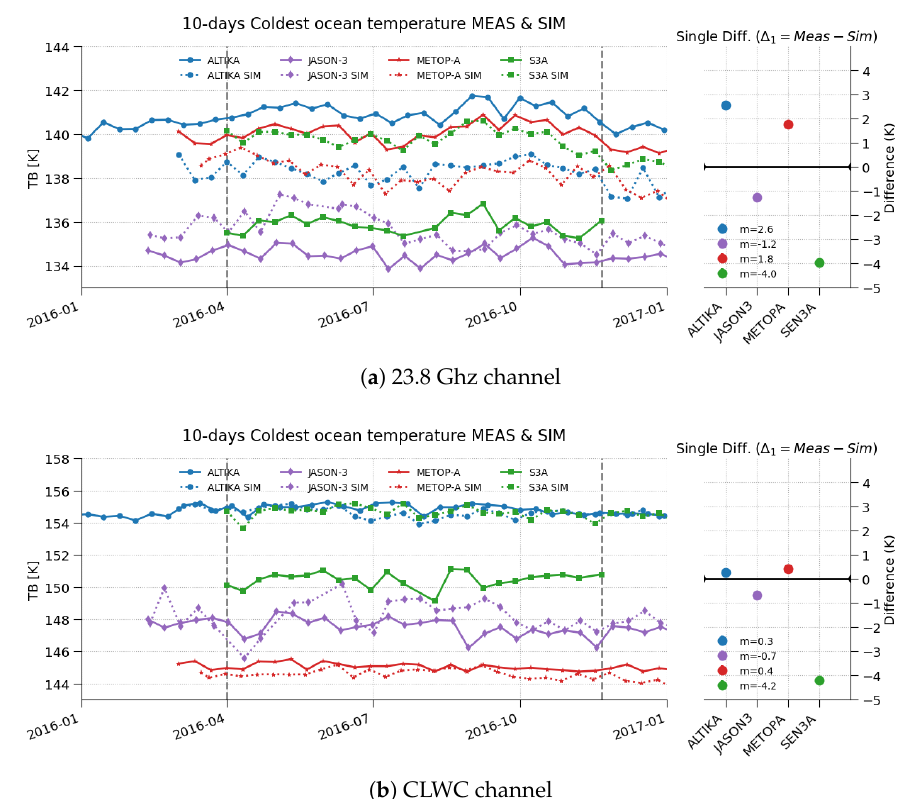
Figure 5. Time series of coldest brightness temperatures over ocean for measurements (full line) and simulations (dotted lines) at 23.8 GHz ( a ) and Cloud Liquid Water Contentchannels ( b ) for Altika, J3, MetOp-A and S3A. The right panels are showing the average single difference computed over the period defined by the two vertical dotted